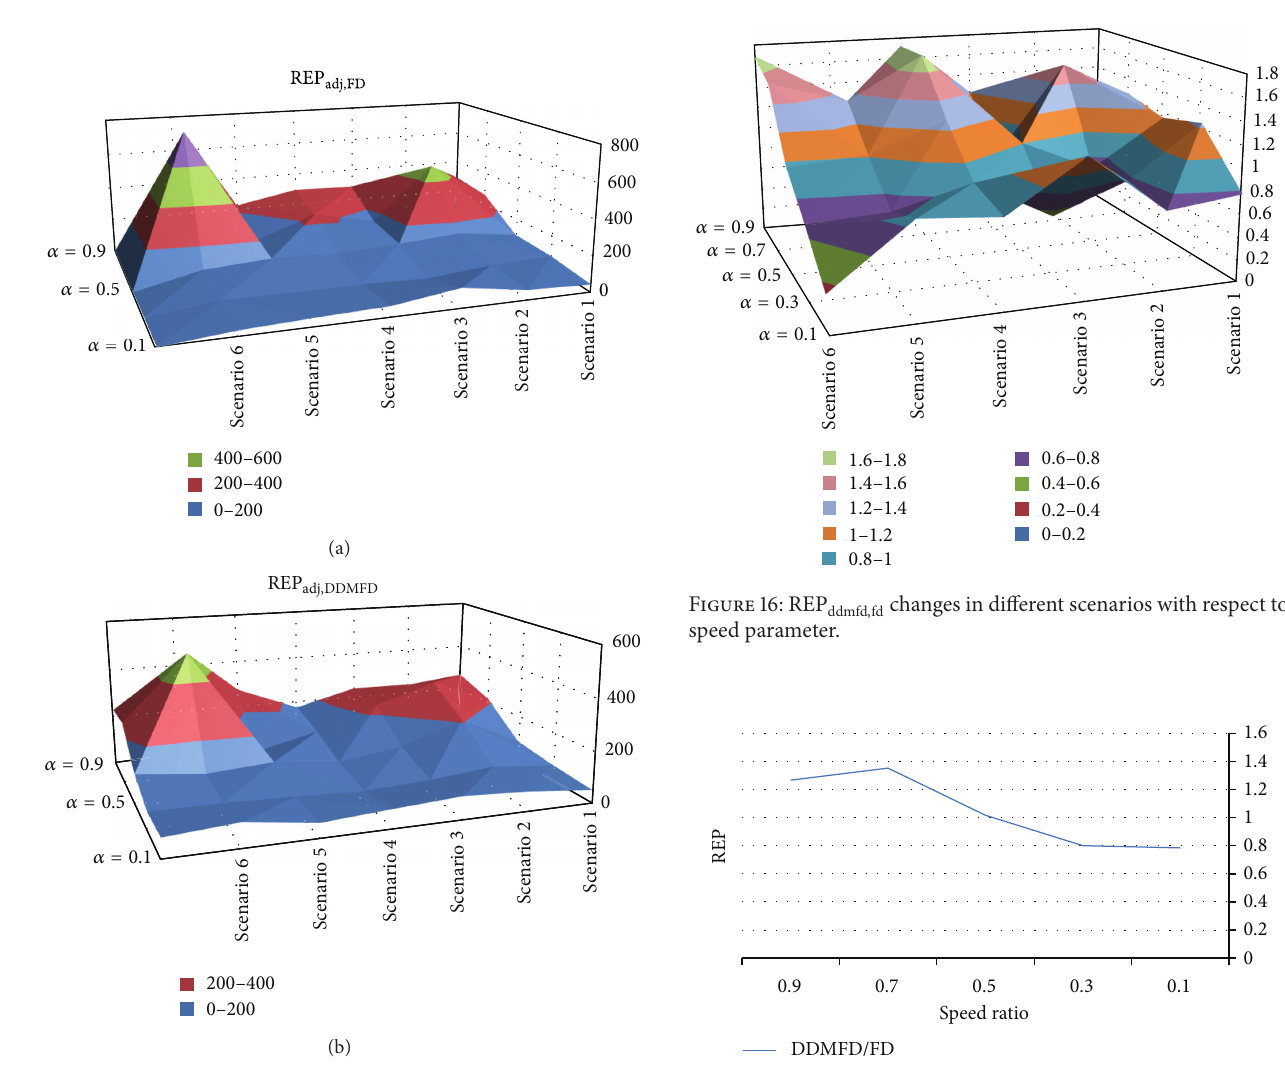
Figure 17: Average of REP